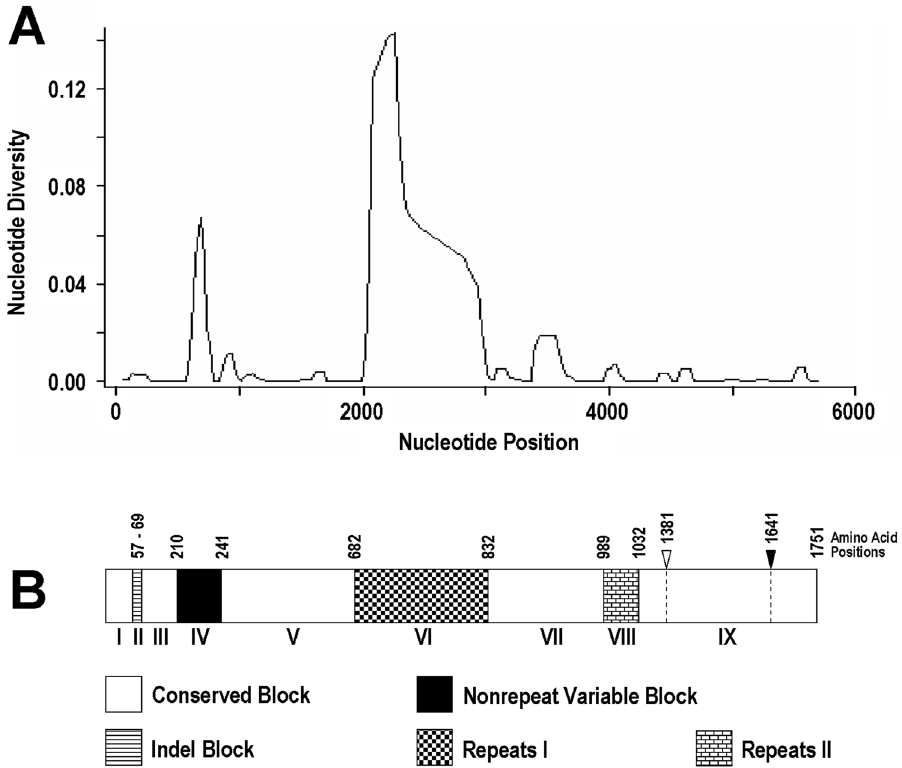
Figure 2. ( A ) Nucleotide diversity across the complete coding region of PmMSP1 using window length of 100 nucleotides and step size of 25 nucleotides. ( B ) Corresponding scheme of PmMSP1 showing organization of the protein regions. The potential cleavage sites for the 42-kDa and 19-kDa fragments are shown in open and filled downward arrow heads,